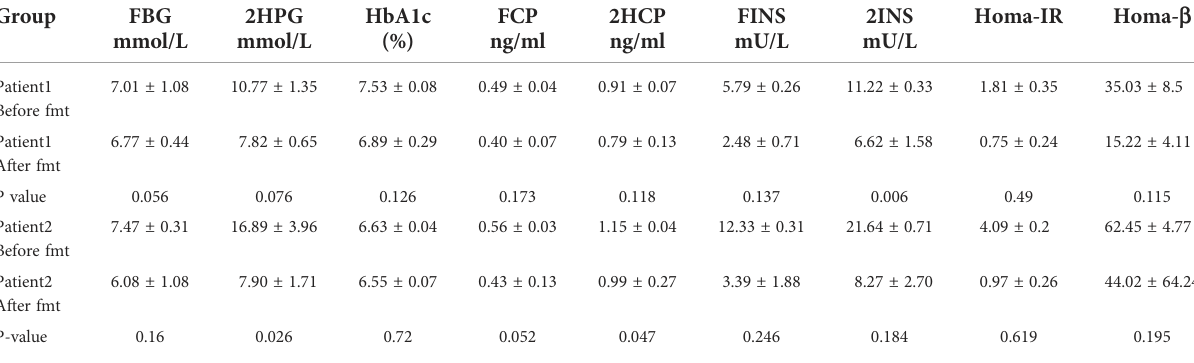
FBG,Fasting glucose; 2HPG, 2-hourpostprandial glucose; HbA1c, glycated hemoglobin;FCP, fasting C-peptide; 2HCP,2-hour postprandial C-peptide; FINS, fasting insulin; 2INS, 2-hour postprandialinsulin;pre-treatmentandpost-treatmentvaluesweregivenasmeanplusorminusstandarddeviation;statisticalanalysiswasperformedusingindependentsamplet-testwith a signi fi cance level of p